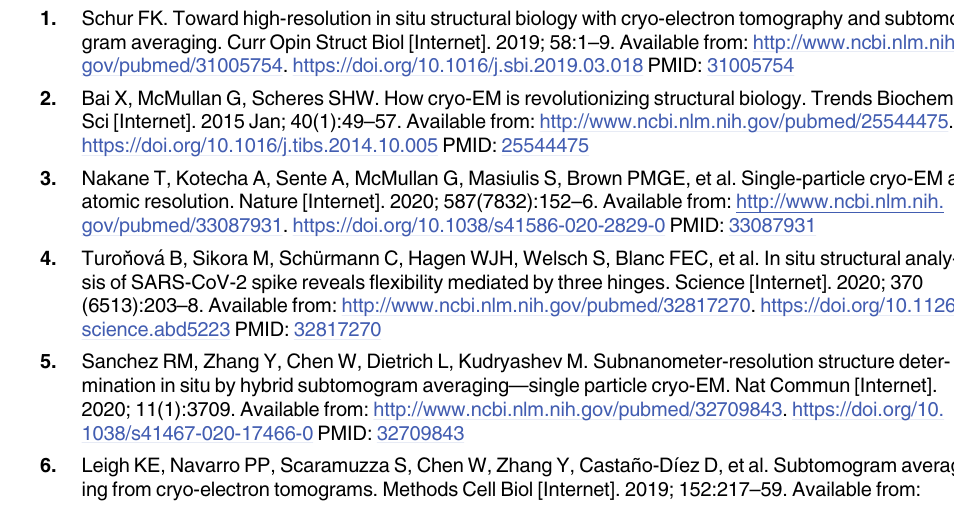
S2 Fig. The source code for generating the scene depicted in Fig 2, combining starfile and eulerangles with existing tools in the scientific Python